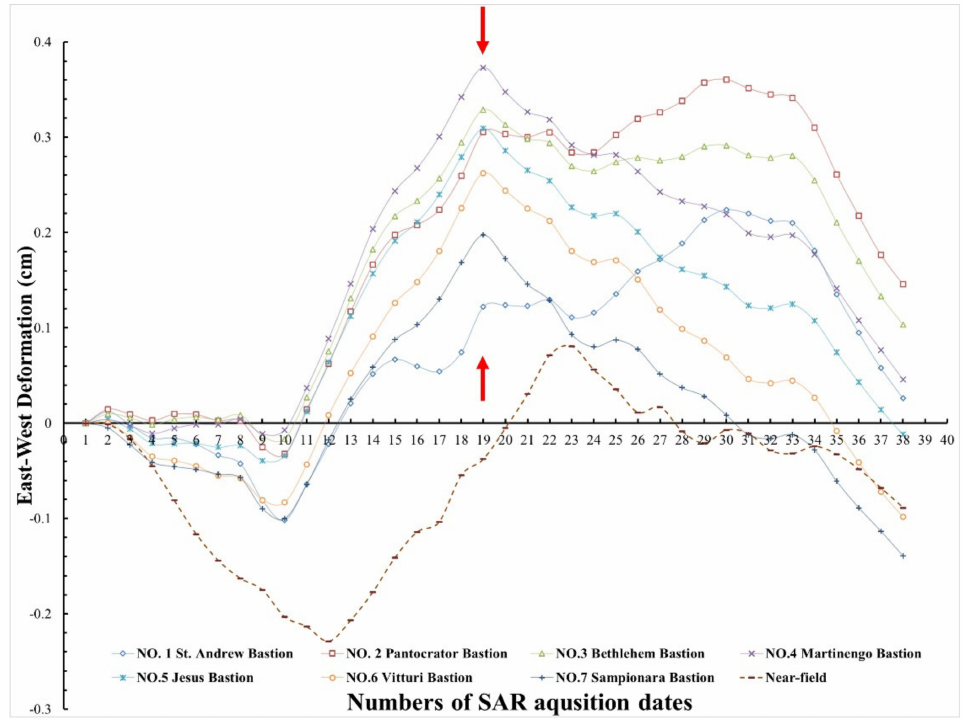
Figure 10. The EW accumulative deformation at the 7 bastions of the HCW and the epicenter. Positive value represents deformation